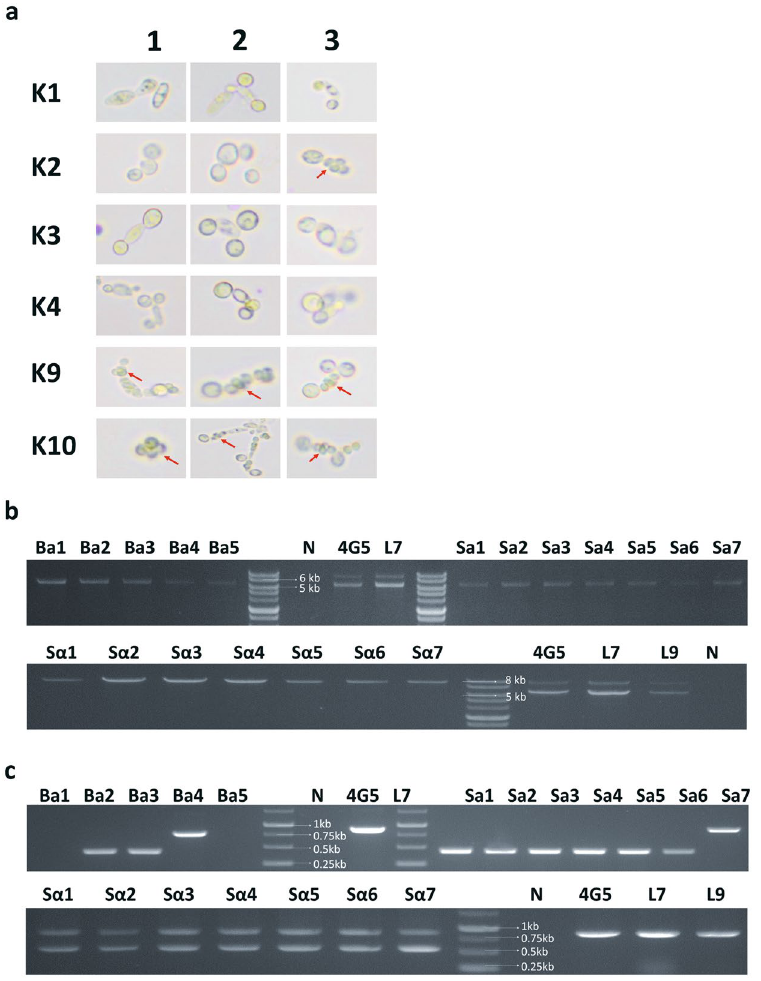
Figure 4. Sporulation and Mat α 3 gene knockout of transformants and validation of mating-type. ( a ) The haploids were obtained by sporulation experiments. The spore locations in the figure were indicated by red arrows. K1, K3 and K4 only showed budding, while K9 and K10 produced spores. One of the three K2 colonies produced spores, while the other two showed budding. ( b ) Confirmation of the MAT type of the isolated spores. In total, we isolated 12 strains of MATa-type and 7 strains of MAT α -type. ( c ) Confirmation of the Mat α 3 gene deletion by PCR in these 12 haploid strains of MATa-type and 7 haploid strains of MAT α